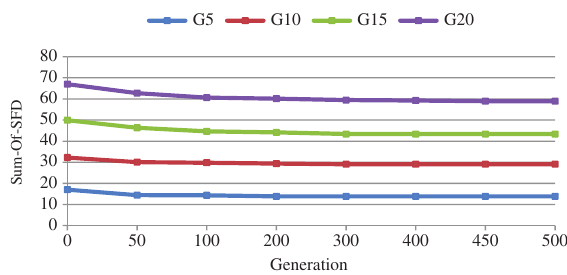
Figure 9: For Different Group Size Variation of Sum-SFD across Generations.